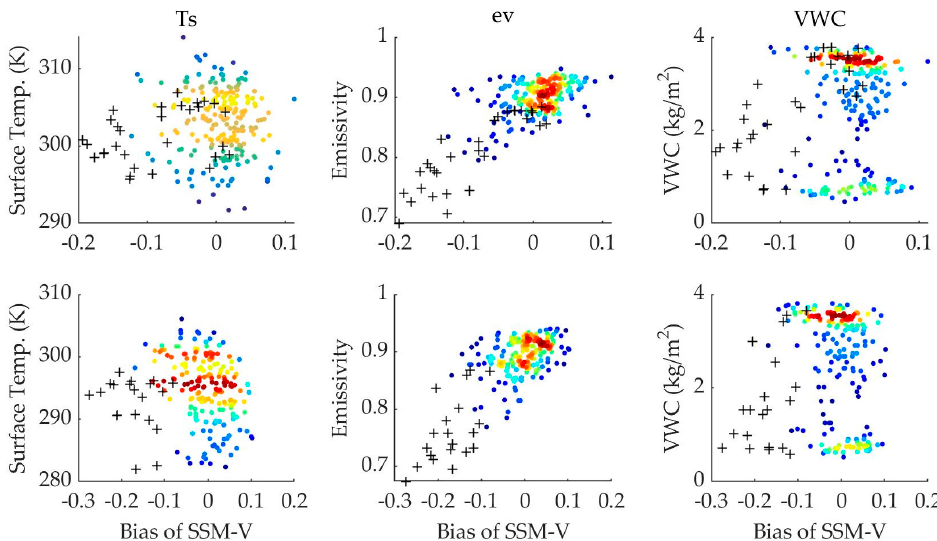
Figure 13. Dependence of SSM bias on inversion model input parameters from 2016–2018. The above three figures show results for ascending orbit and the bottom three figures show results for descending orbit. The cross symbol “ + ” indicates that daily rainfall exceeded 10 mm and the color of the data point indicates the